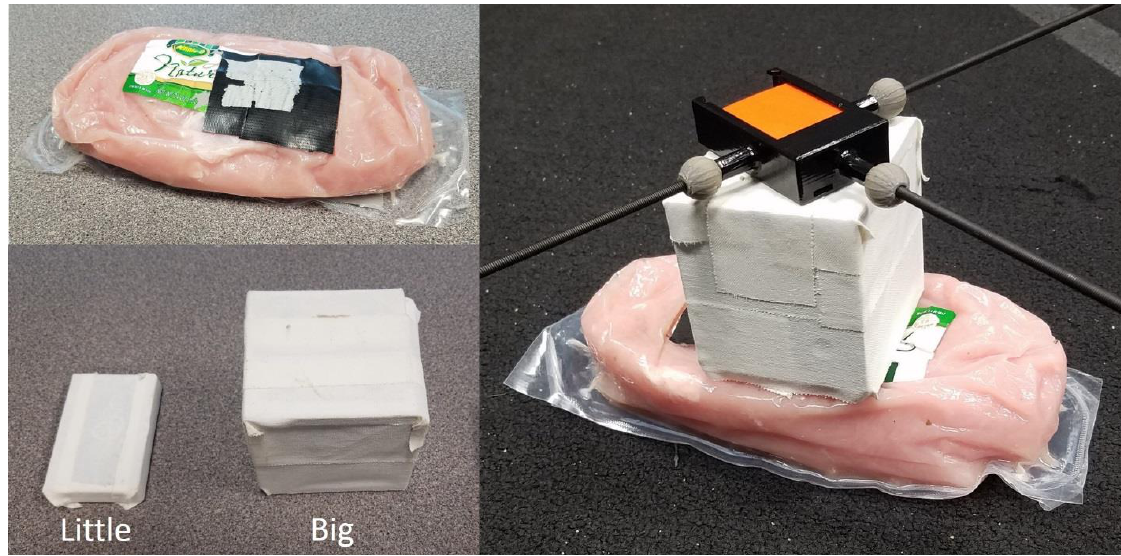
Figure 4. The vacuum-sealed turkey breast tenderloin (top left). The meat weighed ~680 g and had dimensions of approximately 215 by 115 by 45 mm. The blocks (referred to as “ little ” and “ big ”) used to improve the simulation of STA can be seen at lower left. The right-side image shows how the blocks were placed to amplify the relative motion of the sensor to the pendulum so as to improve the simulation of STA.